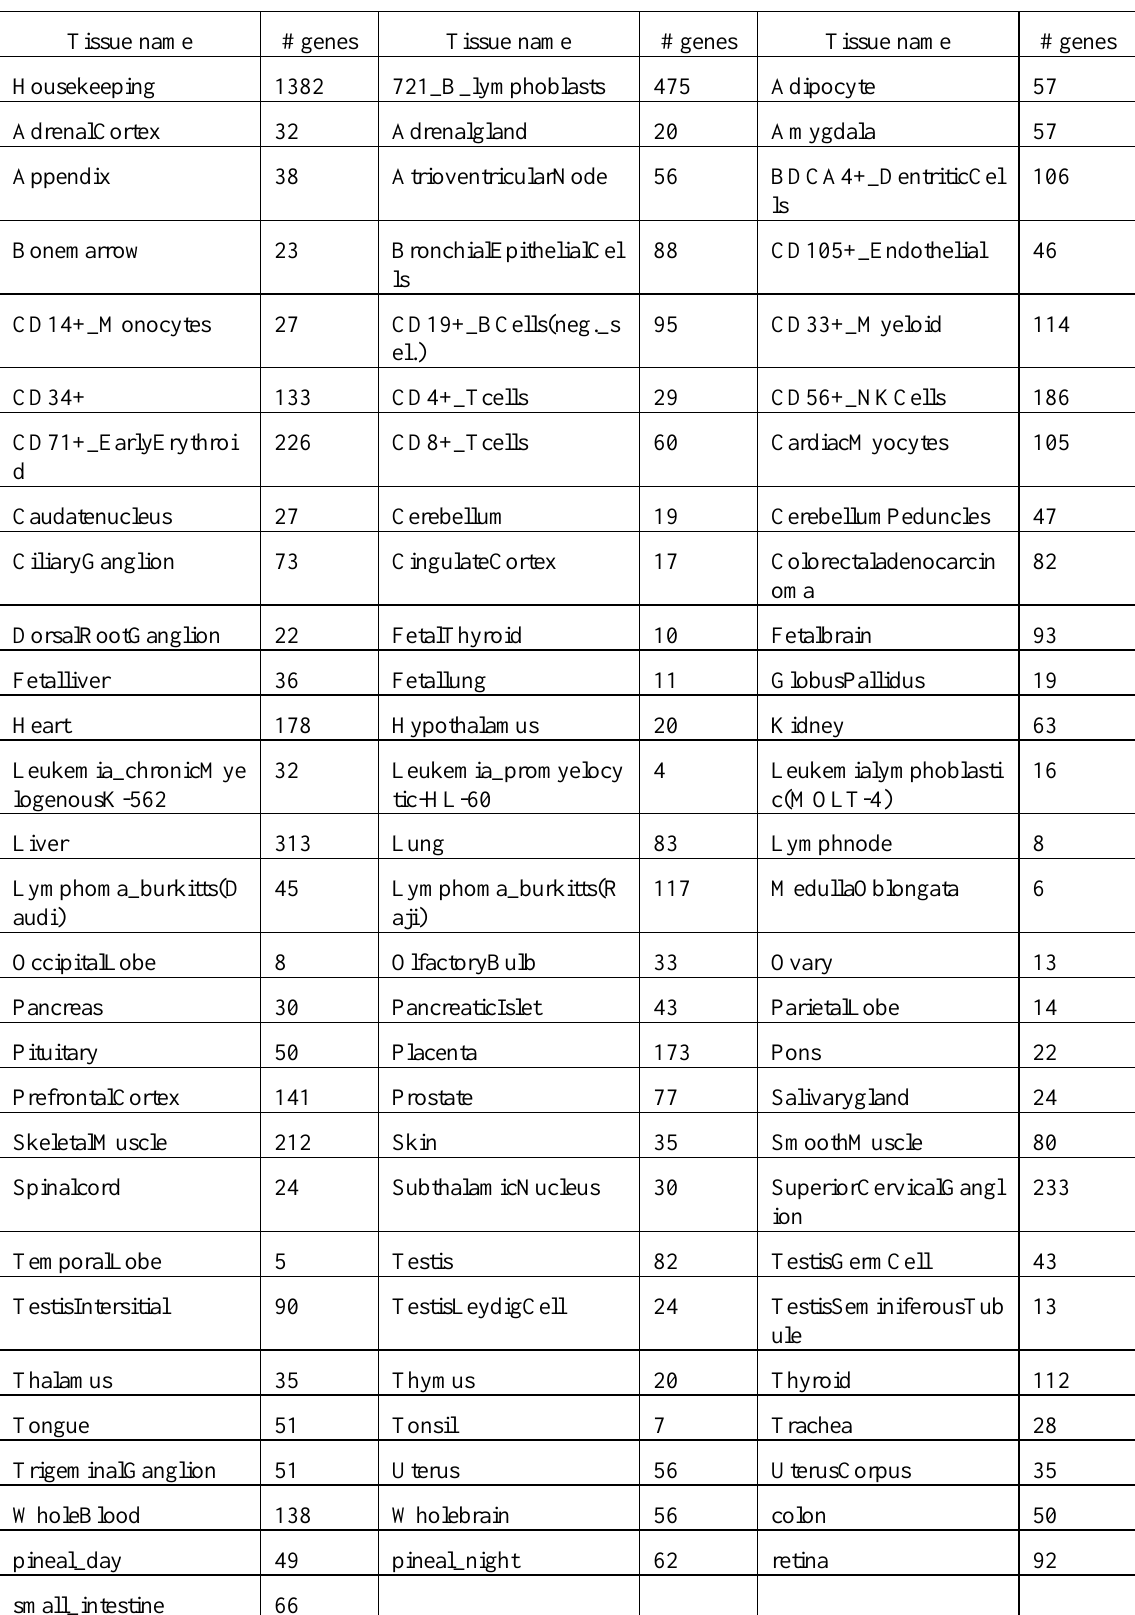
Table 2: The numbers of housekeeping genes and tissue-specific